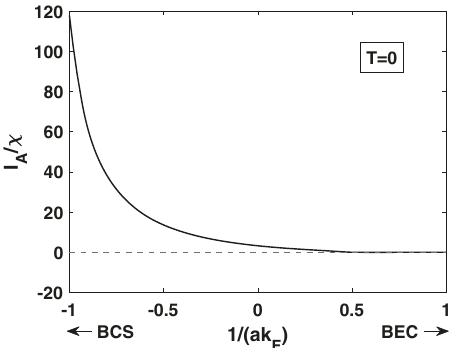
Fig. 4 Andreev current. The solid line shows the Andreev current as a function of dimensionless coupling 1/( ak F ), where k F is the Fermi momentum and a is the scattering length. We take the limit that Δ μ / T → ∞ for simplicity and Δ μ is positive so that the current is on the normal side. Still, χ is the normalizing